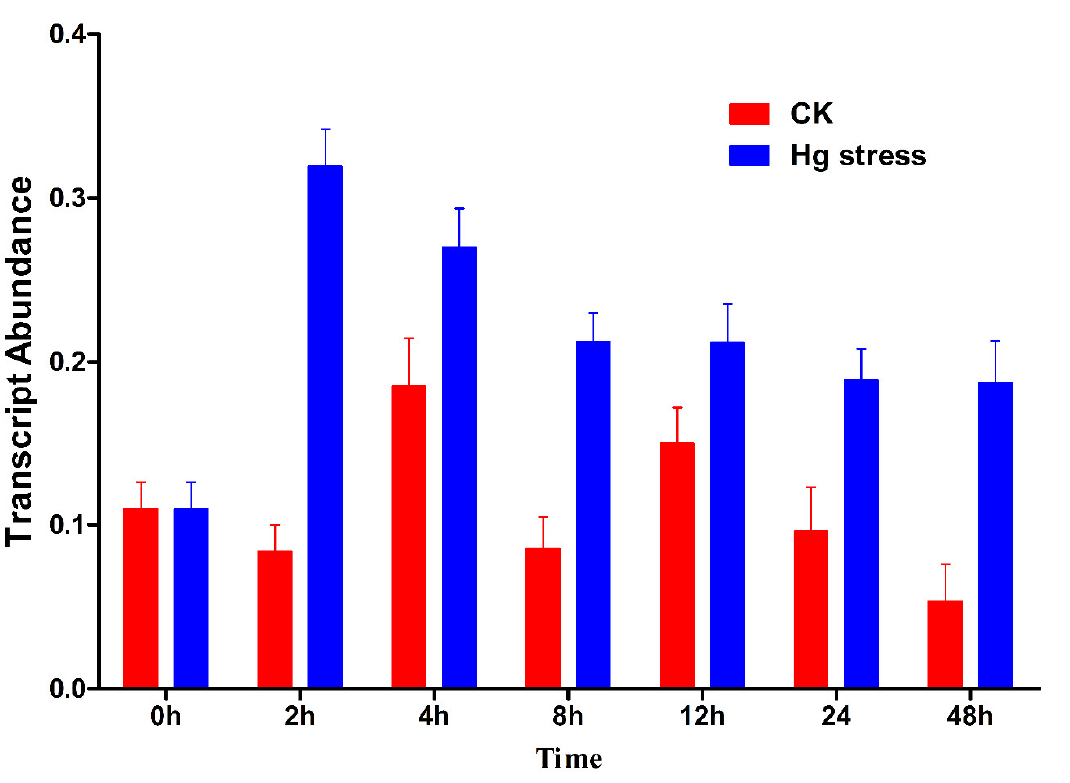
Figure 2. BrCYP71A15 transcription abundance under Hg stresses in Chinese cabbage. The transcript abundance was determined by qRT-PCR in Chinese cabbage seedlings treated with 100 mM Hg. Error bars indicate ± standard deviation.